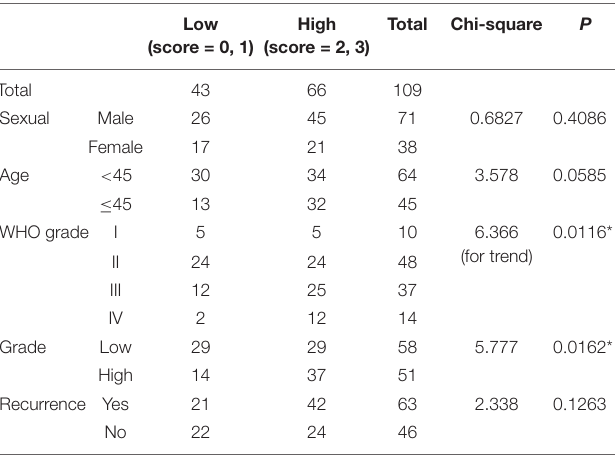
TABLE 1 | Correlation between p-Ezrin(T567) expression and clinical–pathological features in 109 glioma patients. Low High Total (score = 0, 1) (score = 2, 3)